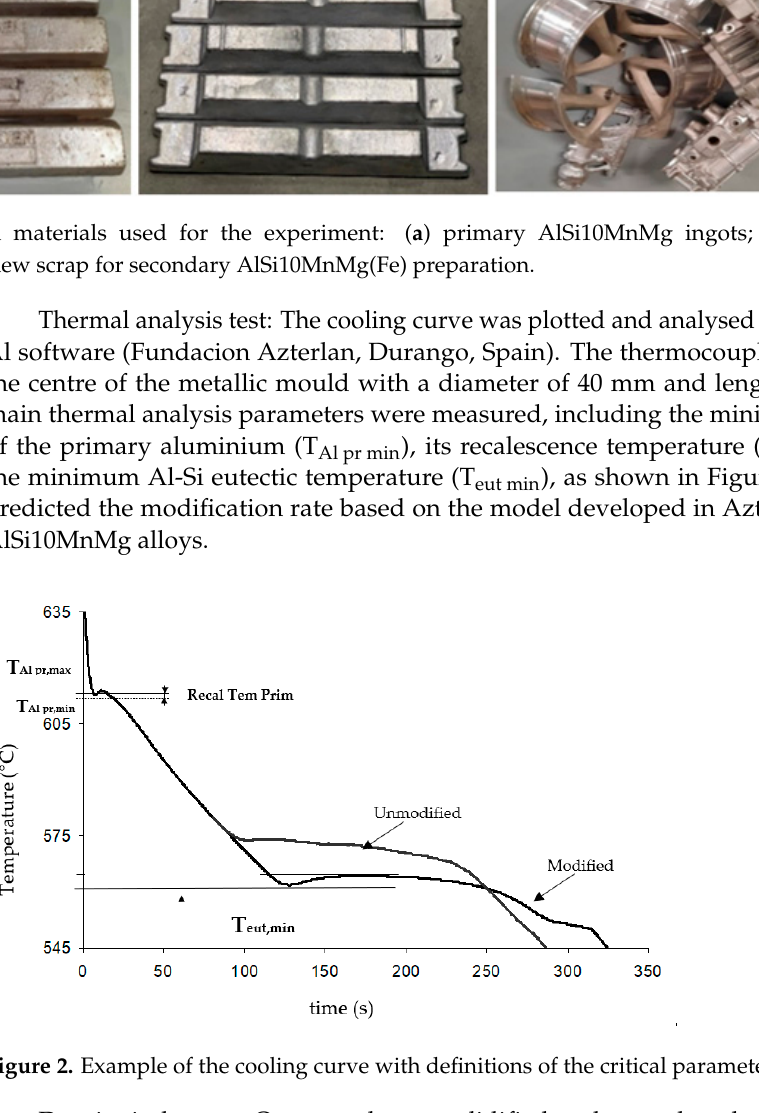
Figure 1. Raw aluminium materials used for the experiment: ( a ) primary AlSi10MnMg ingots; ( b ) secondary AlSi10MnMg(Fe) ingots; ( c ) new scrap for secondary AlSi10MnMg(Fe) preparation.